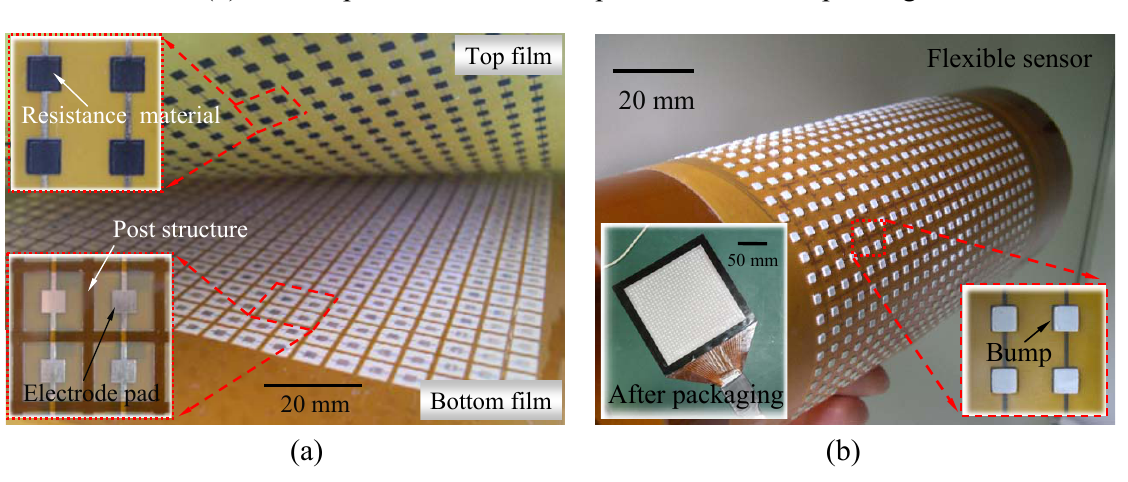
Figure 6. Array sensors of flexible electronics based on polyimide films for large area sensing. (a) Inside view between two PI films, including a resistance layer, posts, and electrodes, and (b) the bump structures on the top film after screen